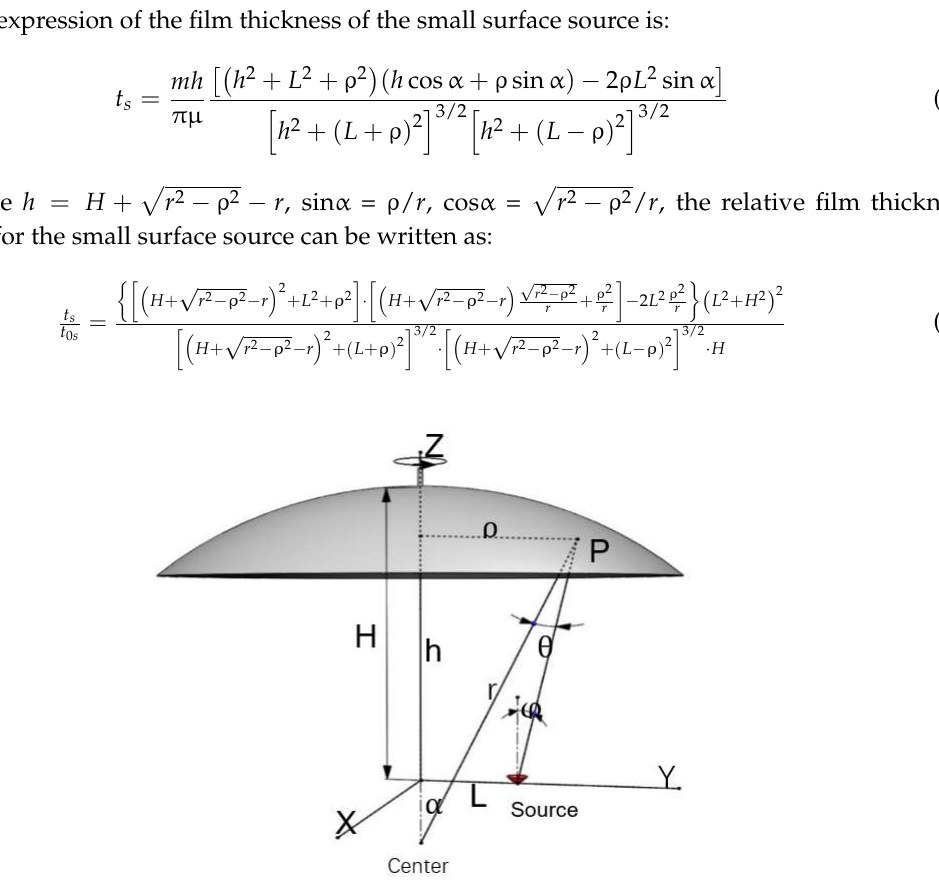
Figure 12. Rotating spherical substrate holder, where H is the distance between the source and the top of the substrate holder, h is the height of sample to the source position, φ is the angle between the normal of the source and the line connecting the source to the P point; θ is the angle between the normal of the substrate and the line connecting the source to the P point; ρ is the distance from the center of the substrate holder to the P point; r is the distance from the source to the P point; L is the distance from the source to the center; P is any point on the substrate holder.